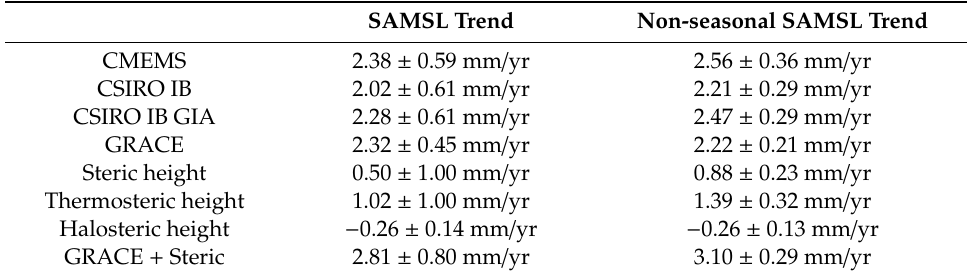
Figure 5. South Atlantic mean sea level (SAMSL) time series derived from ( a ) CMEMS, CSIRO and CSIRO corrected by GIA, ( b ) GRACE and Argo (steric height) and ( c ) average of CMEMS and CSIRO corrected by GIA (SLA) and the sum of GRACE (SM) and Argo (SH) for the period January 2005 to December 2016. The dashed lines represent the linear regression. The blue, red and black shaded areas represent one standard error. Units: mm. Table 2. South Atlantic mean sea level (SAMSL) trends (mm / yr) derived from CMEMS, CSIRO, GRACE and Argo for the period January 2005 to December 2016. Trend values shown in bold are statistically significant at the 95% significance